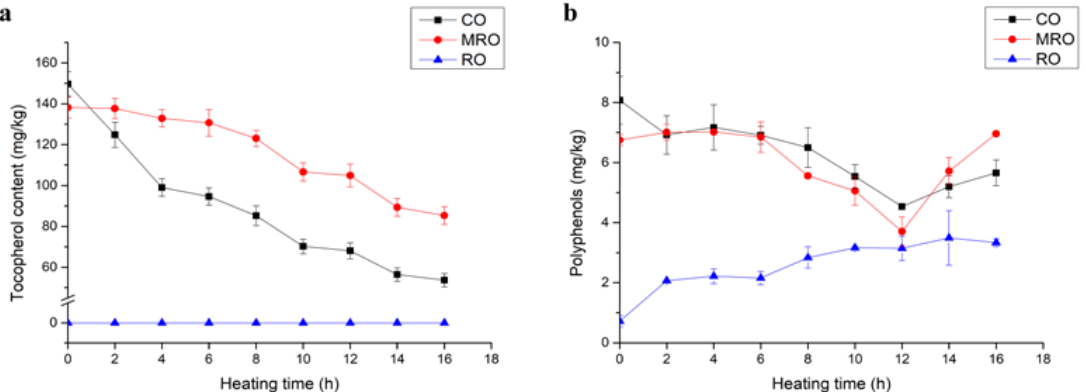
Figure 7. Changes in ( a ) tocopherol and ( b ) polyphenols contents in three kinds of camellia oil during heating.